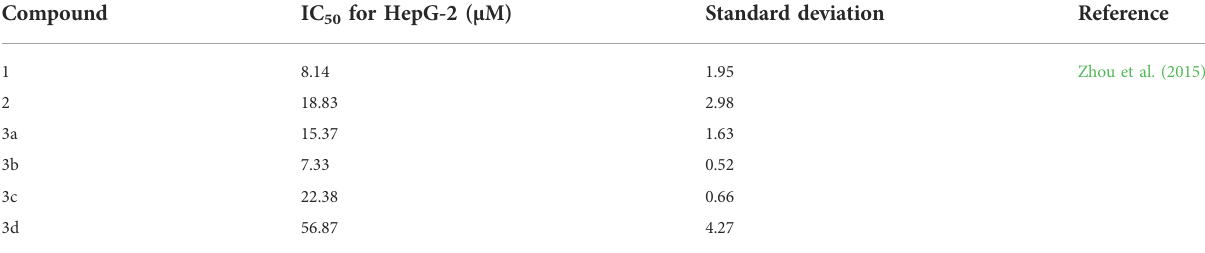
TABLE 2 The IC 50 value of the compounds bearing juglone skeleton.